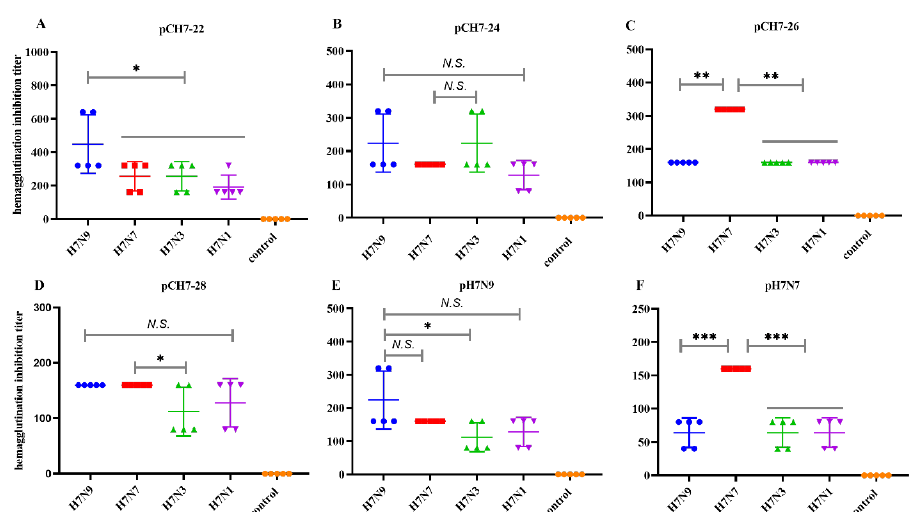
Figure 5. DNA vaccines encoding consensus H7 proteins elicit broad HAI antibody responses in mice. Sera from each group of immunized and unimmunized mice were serially diluted by two-fold with PBS in a 96-well polystyrene microtiter plate with 25 µ L in each well. A portion of 25 µ L virus suspension containing 4 hemagglutinin units (HAU) H7N9, H7N7, H7N3, and H7N1) were added to each well. After incubation of the plate at room temperature for 1 h, 50 µ L of 0.5% (v / v) chicken red blood cells were added to each well, and the plate was incubated at room temperature for 30 minutes. HAI titers were determined as the highest serum dilution that completely inhibited hemagglutination. Values are the mean titers plus the standard error of the mean (error bars) ( A – F ). Statistical significance was analyzed by t test or Mann-Whitney Test. p values shown in bar charts and N.S. indicates no significance between two compared groups. * p < 0.05, ** p < 0.01 and *** p < 0.001 between indicated groups.